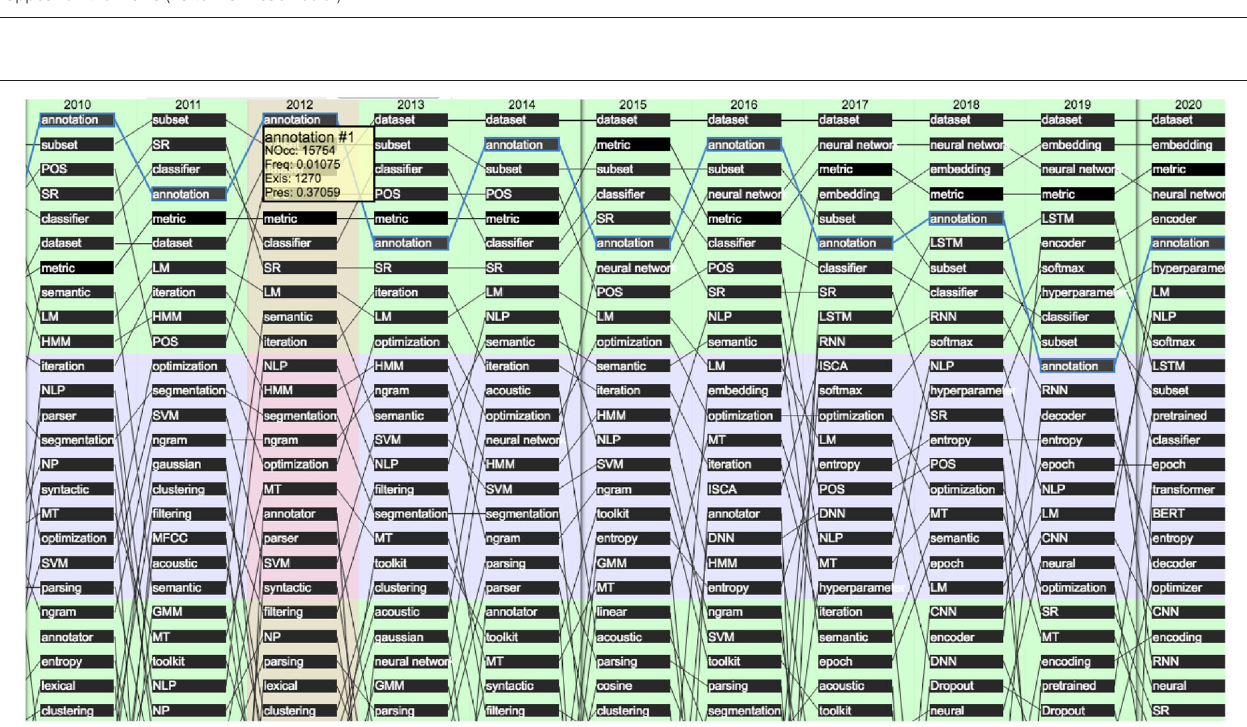
FIGURE 31 | Overview of the GapChart (2000 to 2011) illustrating the parameters. Years appear on the X-axis, and ordered terms (here according to their presence) appear on the Y-axis (10 terms in each color).